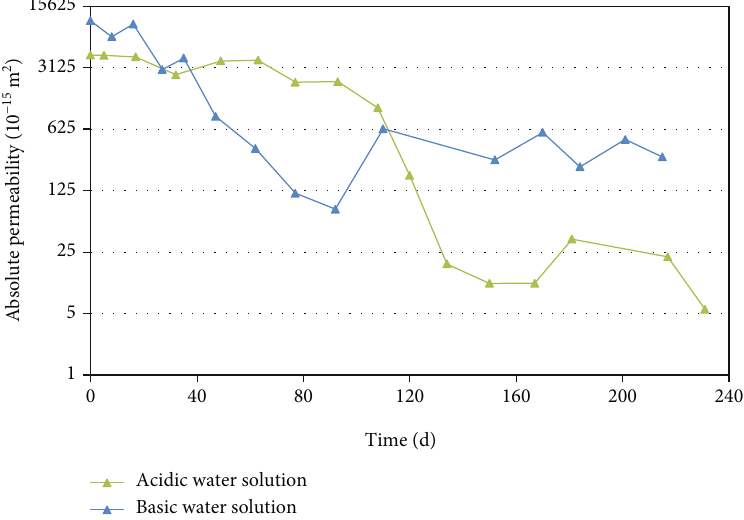
Figure 4: Absolute permeability over time of a previously reported prefractured sandy mudrock specimen